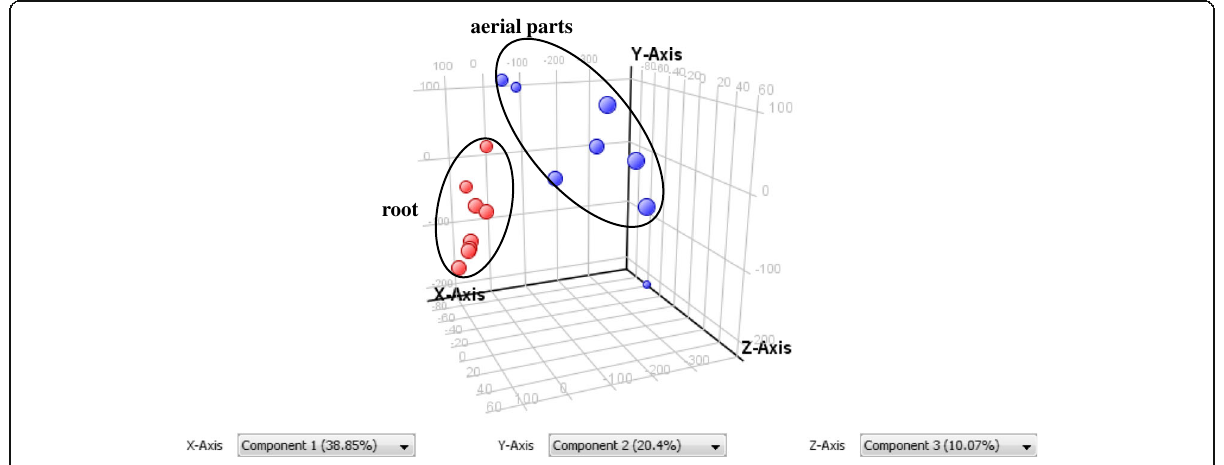
Fig. 4 The principal component analysis (PCA) of the root ( red ) and aerial ( blue ) parts from eight batches of Bupleurum samples